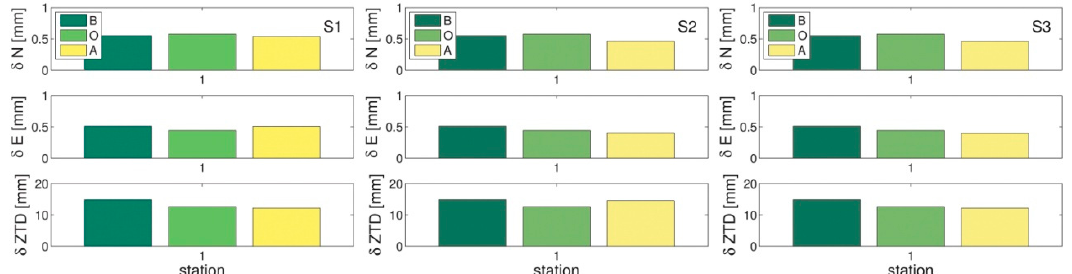
Figure 9. The root mean square errors of ZTDs and the horizontal delay gradients for the Background (B), the Observation (O) and the Analysis (A). Left panel: ZTDs are assimilated. Middle panel: Horizontal delay gradients are assimilated. Right panel: ZTDs and horizontal delay gradients are assimilated. GNSS ZTDs and horizontal delay gradients from the G-Nut/Tefnut software for the single station Potsdam are assimilated four times per day (0, 6, 12, 18 UTC) for a period of two months (June and July, 2017).